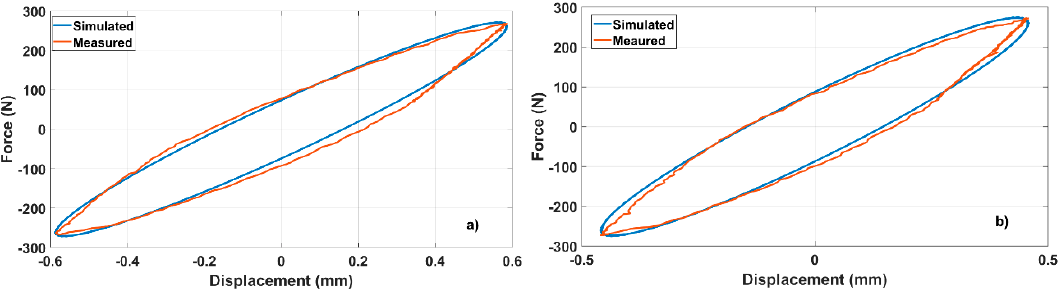
Figure 19. Simulated–measured cycle comparison: ( a ) 15 Hz frequency, 0 A current; ( b ) 15 Hz frequency, 6 A current.